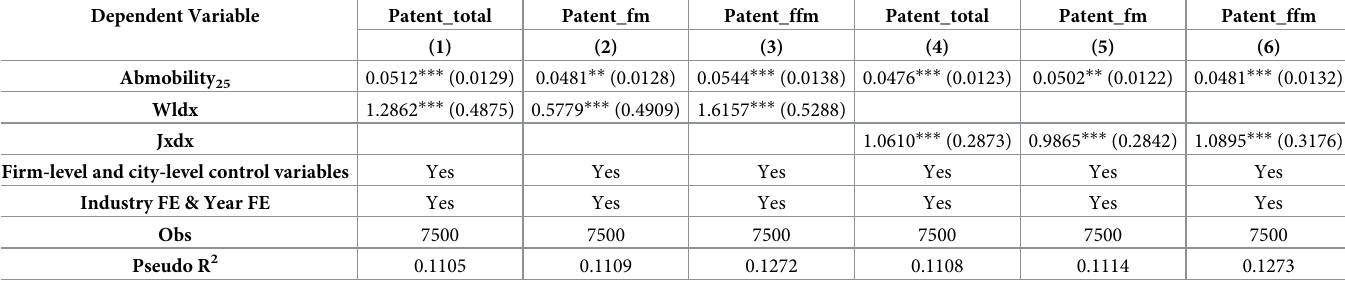
Table 6. Results of controlling regional culture.